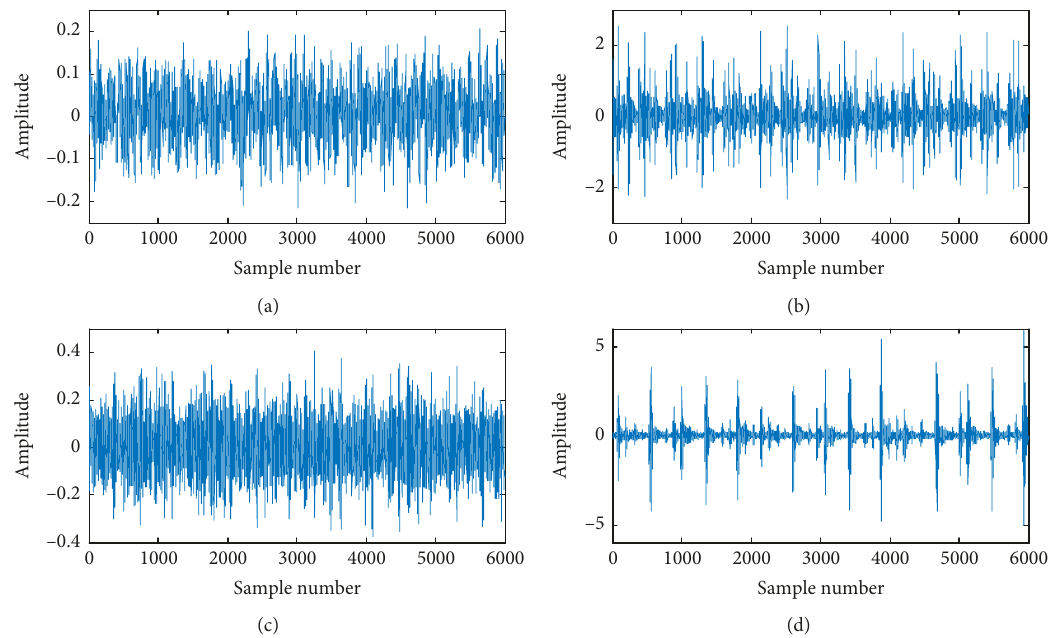
Figure 4: The time domain diagram of CWRU signals, where (a)–(d) represent normal bearing signal, inner race fault signal, ball fault signal, and outer race fault signal, coming from 99, 211, 224, and 236 of CWRU, respectively. Each signal is listed with the sample number 6000.